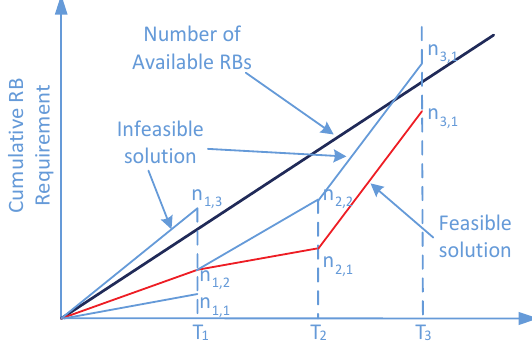
Figure 3: Analysis of the